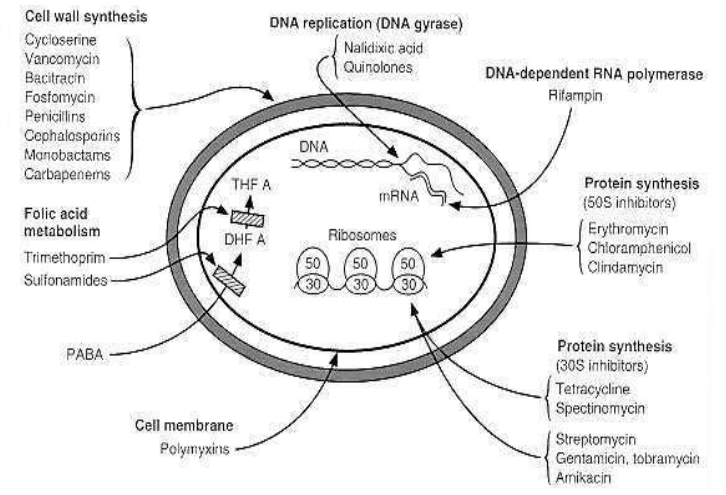
Figure 1. Sites of action of different antimicrobial agent’s PABA, DHFA,